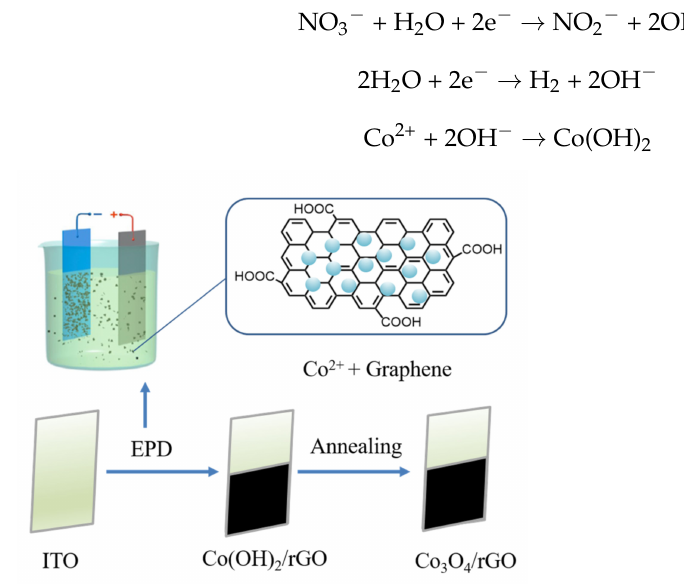
Figure 1. Schematic illustration of the fabrication of the Co 3 O 4 /rGO